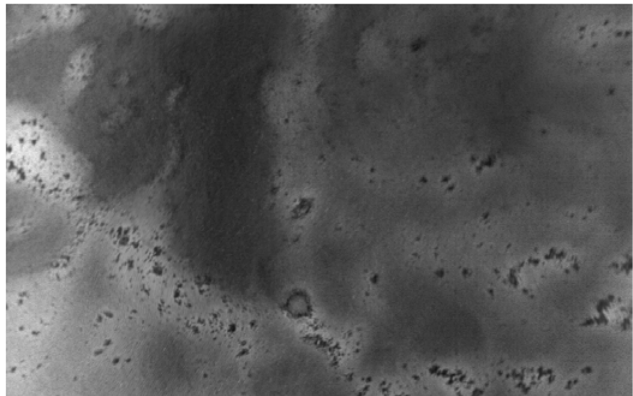
Figure 3. First derivative between spectral bands 3 and 4 of the Red Sea dataset undergone through a denoising step with UBD.